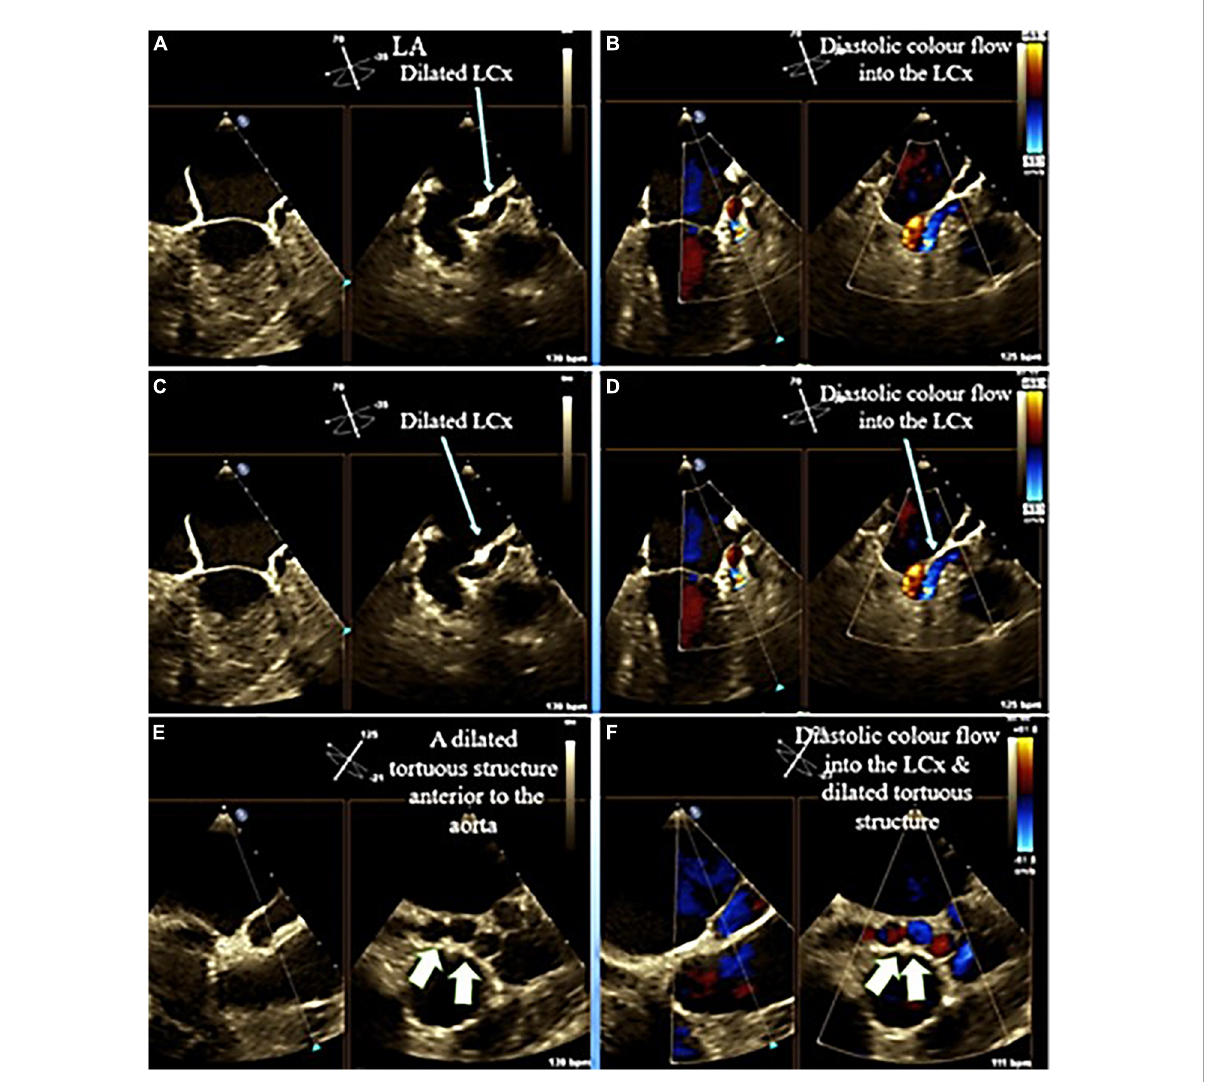
FIGURE4 Mid esophageal echocardiography in different views illustrates dilated left circumflex (light blue arrow) as well as a giant tortuous structure (fistula) (white arrow) posterior to the